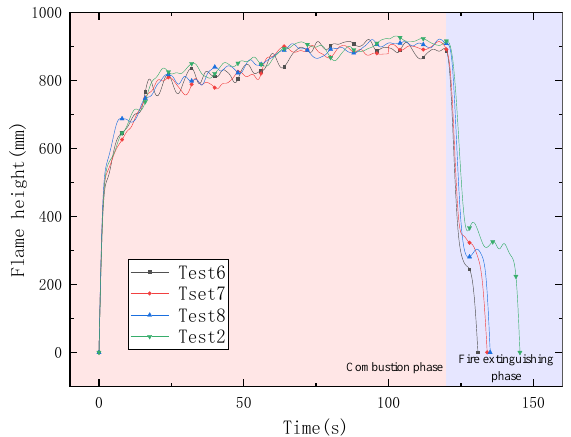
Figure 7. Average flame heights at different pipe diameters.